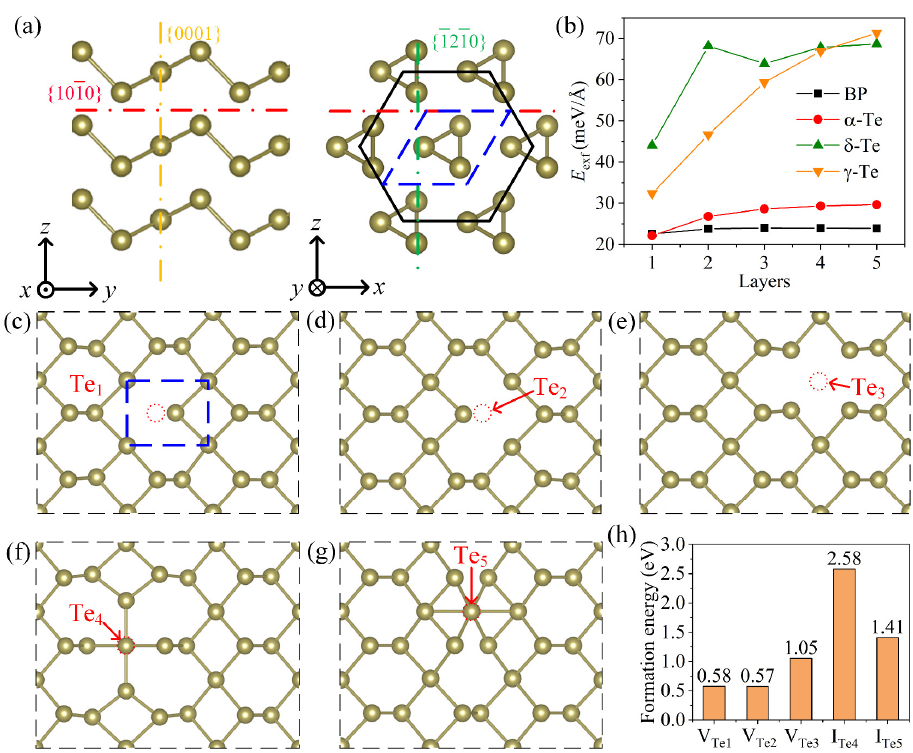
Figure 5. Exfoliation of Te flake and formation of defect. ( a ) atom structure of Te flake; ( b ) exfoliation energy of cutting along the { 1010 }, { 0001 }, and { 1210 } planes; relaxed atom structures with three vacancies V Te1 ( c ), V Te2 ( d ), and V Te3 ( e ) and two interstitials I Te4 ( f ) and I Te5 ( g ); ( h ) the formation energy of five possible defects.